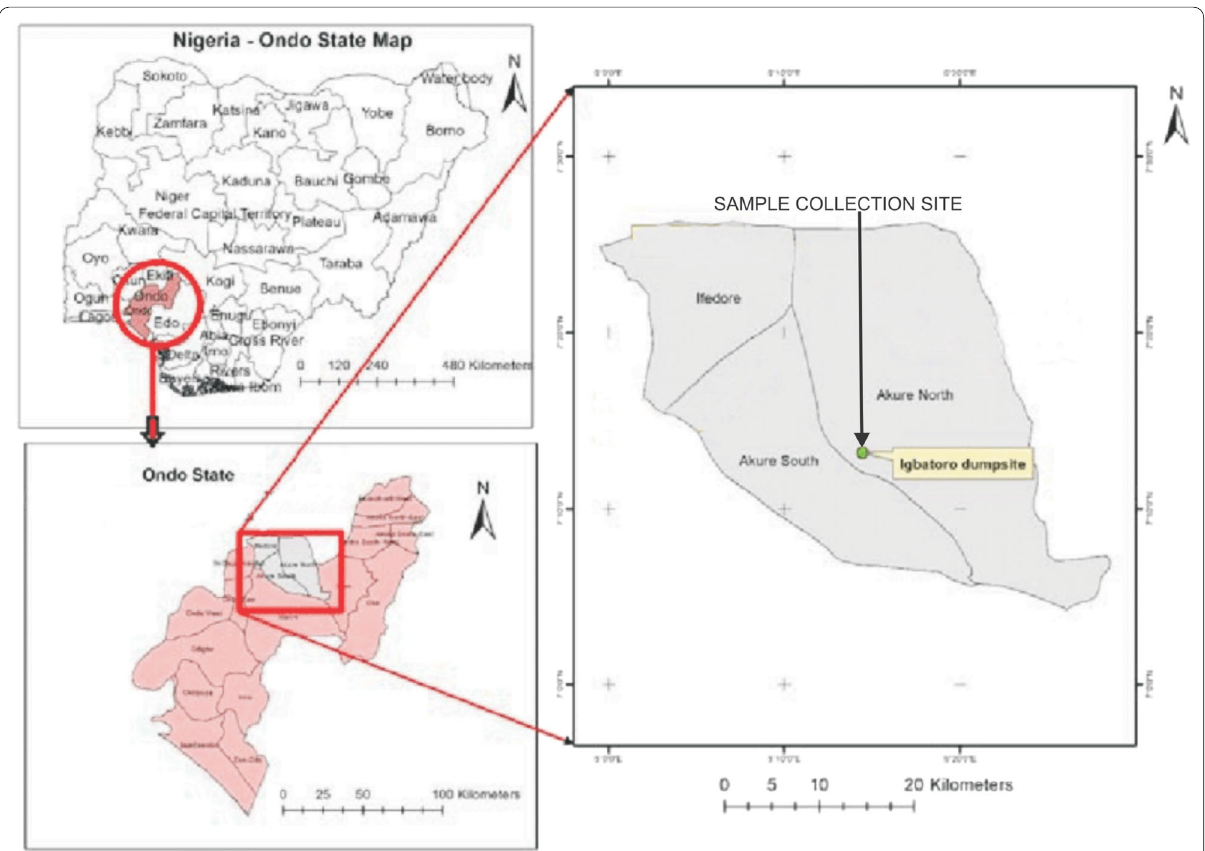
Fig. 1 Map of study area/sample collection